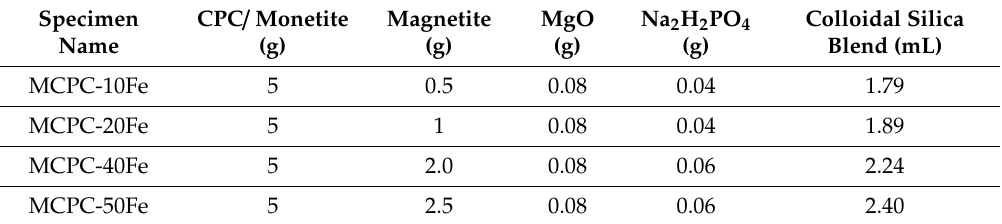
Table 1. Di ff erent compositions used for developing magnetic cements. MCPC indicates magnetic calcium phosphate cement, and Fe indicates magnetite